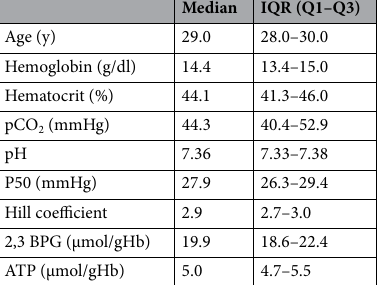
Table 2. Baseline characteristics of the study population (median and interquartile range, IQR). pCO